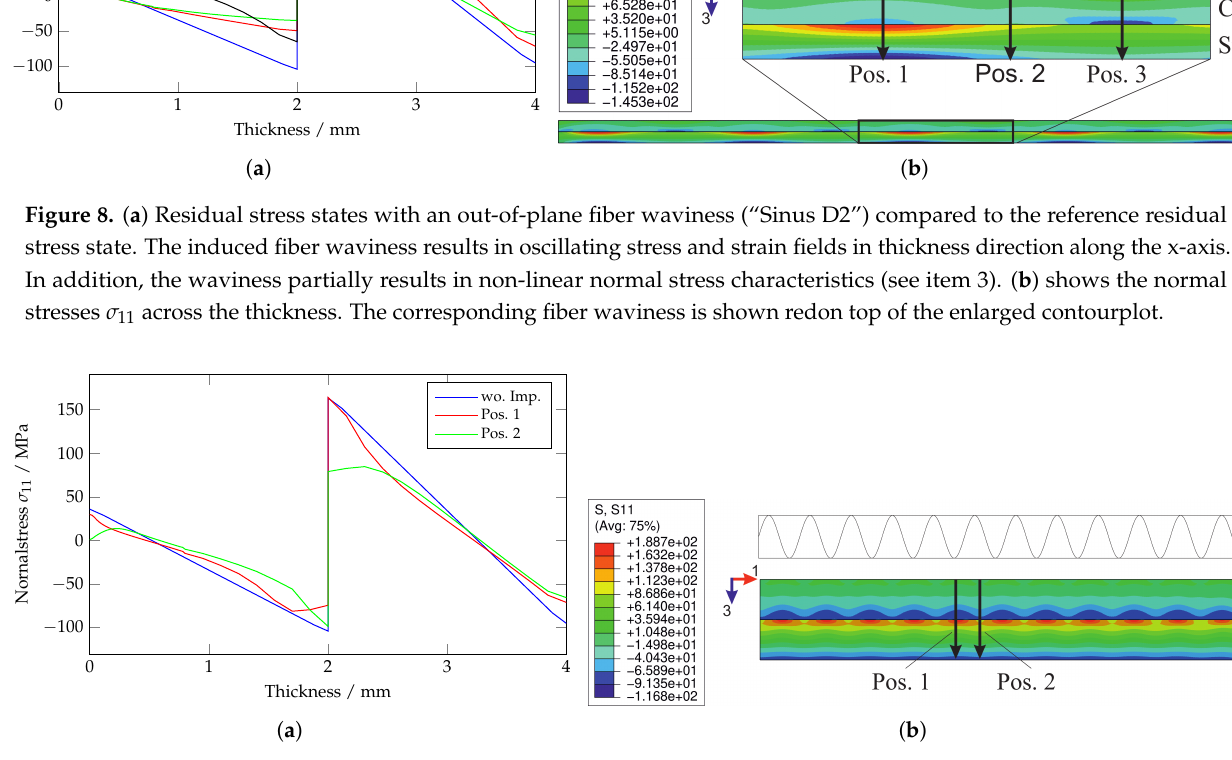
Figure 9. ( a ) Residual stress states with an out-of-plane fiber waviness (“Sinus D1”) compared to the reference residual stress state. The induced fiber waviness results in oscillating stress and strain fields in thickness direction along the x-axis. ( b ) The Normal stresses σ 11 across the thickness. On the top of the enlarged contour plot the corresponding fiber waviness is shown.